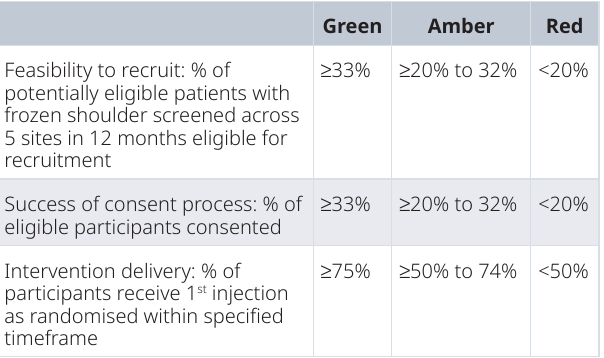
Table 3. Progression criteria.